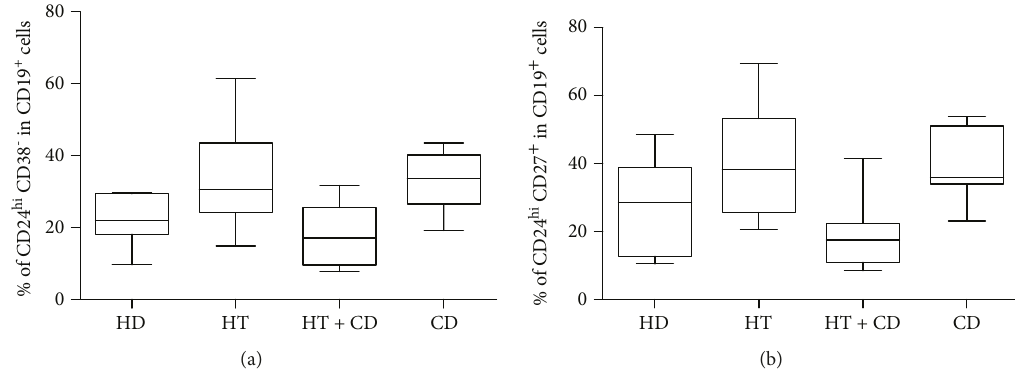
Figure 3: Nonstimulated Breg memory cells. (a) Percentage of Breg memory cells (CD24 hi CD38 − ) in healthy donors (HD), in patients with isolated Hashimoto thyroiditis (HT), in patients with Hashimoto thyroiditis plus celiac disease (HT+CD), and in patients with celiac disease (CD). Box plots indicate median, interquartile range (box), and minimum and maximum values (whiskers). Nonparametric Kruskal-Wallis test p = 0 0065 . Dunn posttest: HT vs HT +CD p < 0 05 and HT+CD vs CD p < 0 05 . (b) Percentage of Breg memory cells (CD24 hi CD27 + ) in healthy donors (HD), in patients with isolated Hashimoto thyroiditis (HT), in patients with Hashimoto thyroiditis plus celiac disease (HT +CD), and in patients with celiac disease (CD). Box plots indicate median, interquartile range (box), and minimum and maximum values (whiskers). Nonparametric Kruskal-Wallis test p = 0 0122 . Dunn posttest: HT vs HT +CD p < 0 05 and HT +CD vs CD p < 0 05 .